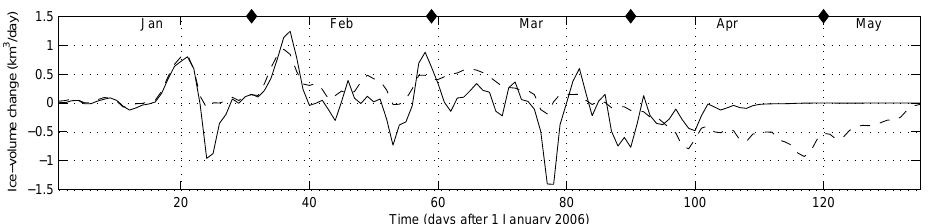
Fig. 9. The rate of change in the total ice volume V ice (in km 3 d − 1 ) in the Bothnian Bay in winter 2005/2006, as obtained with the dynamic- thermodynamic (continuous line) and purely thermodynamic (dashed line) ice model.